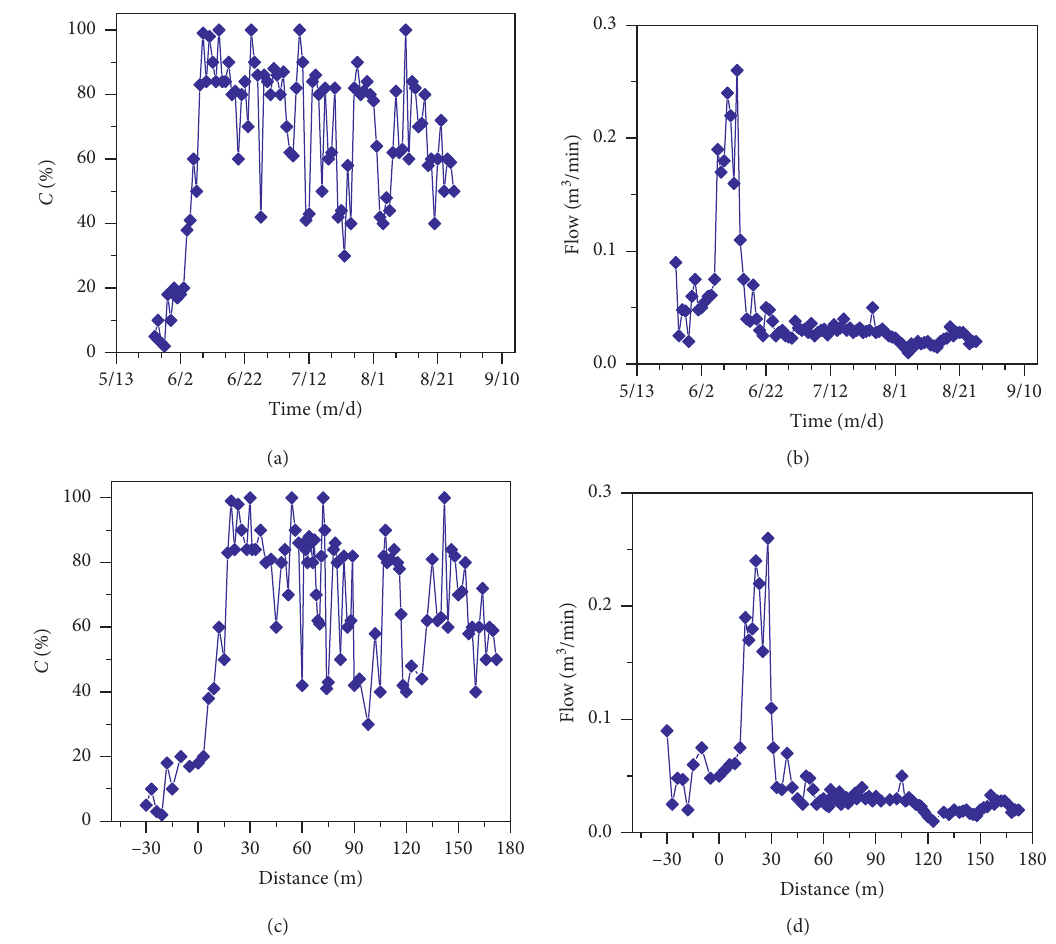
Figure 9: Gas monitoring data in no. 2 borehole of group